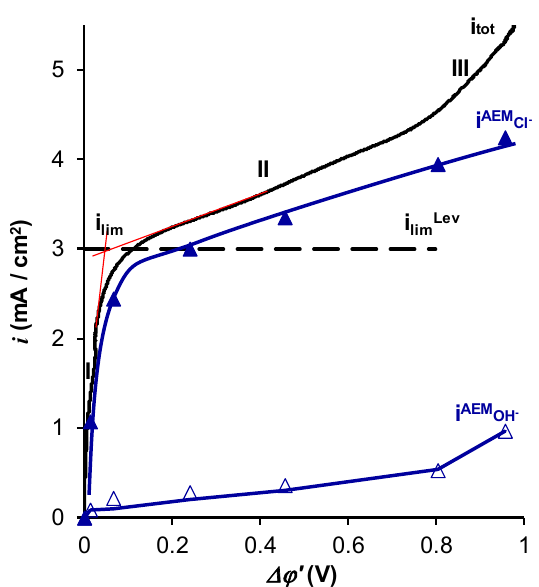
Figure 1. Total and partial current–voltage characteristics of the AMX membrane in a 0.02 M NaCl solution; i tot is the total current density, i AEM ions through the membrane, respectively. The dashed lines show the tangents to the CVC used to determine the experimental limiting current density.